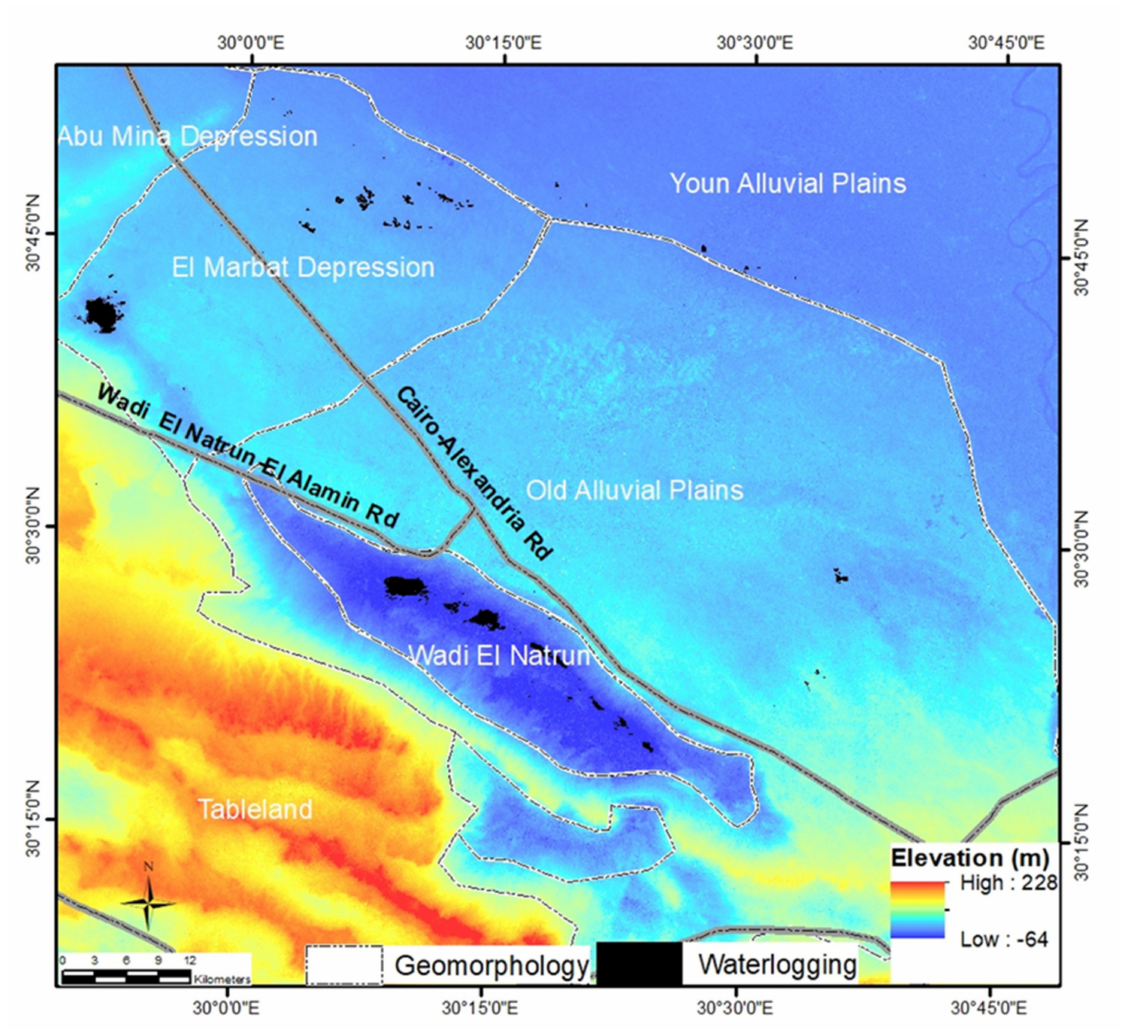
Figure 2. Geomorphological subdivision displayed on the shuttle radar topography mission (SRTM) digital elevation model. Waterlogging patches are shown in black